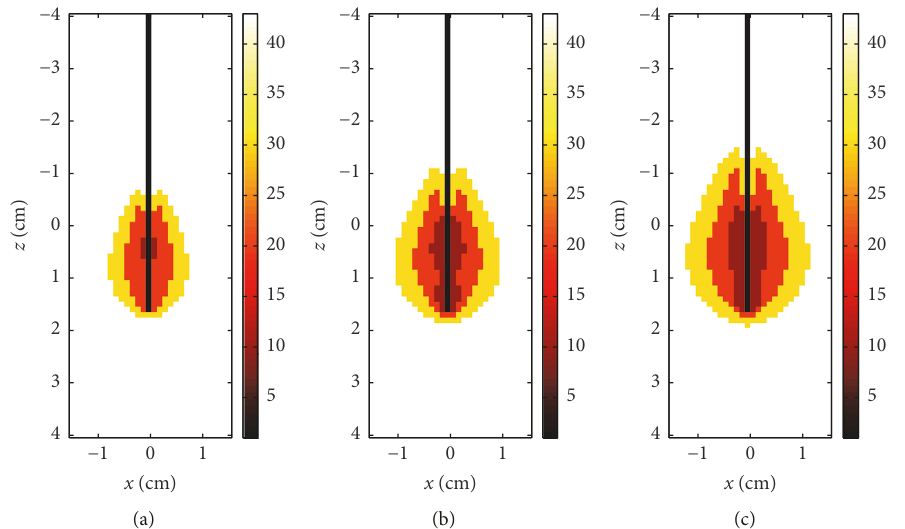
Figure 3: Relative permittivity map of the simulated scenario for 𝑡 = 60 s (a), 𝑡 = 120 s (b), and 𝑡 = 180 s (c). With respect to Table 1, untreated liver is mapped in white, and the three liver tissues labeled as Ablated Livers 1, 2, and 3 are rendered in yellow, red, and dark red, respectively.